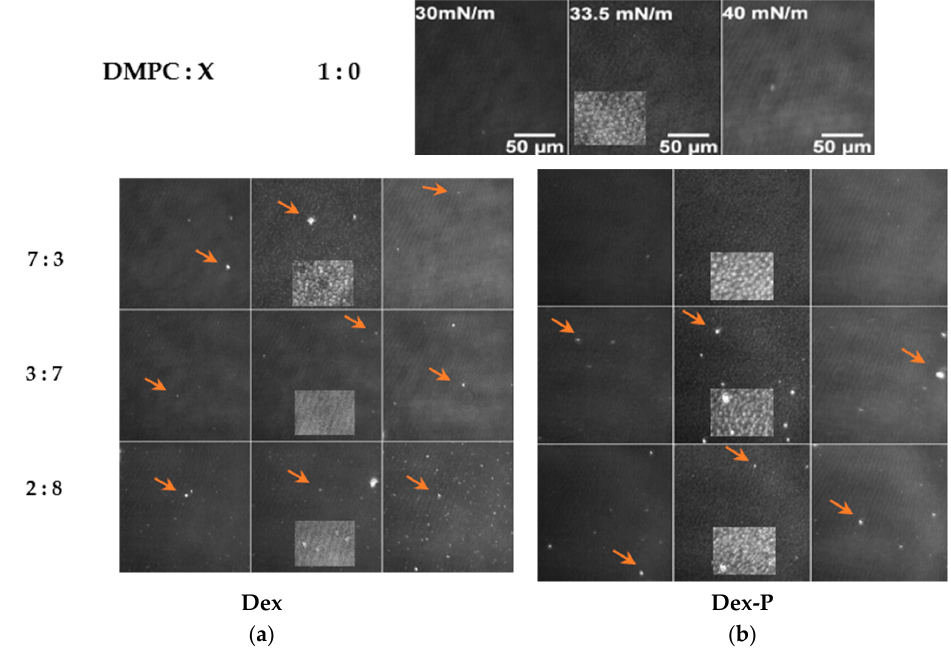
Figure 3. Brewster angle images at different surface pressures for DMPC: X, X = ( a ) Dex and ( b ) Dex-P. The images correspond to the Langmuir isotherm shown in Figure 2a,b. To a better visualization, the images brightness were adjusted from 0–255 to 8–60. Inset: zoom with increases contrast (14–41). Orange arrows indicates aggregates.